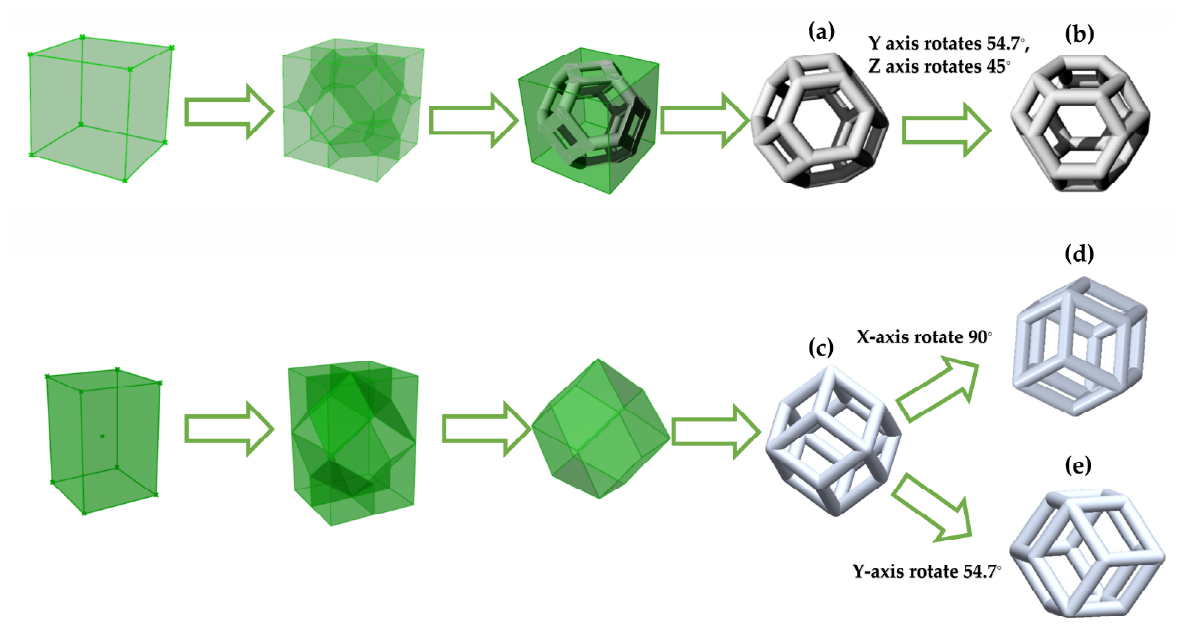
Figure 2. Design process of random Voronoi structure: ( a ) Octa-A, ( b ) Octa-B, ( c ) Dodeca-A, ( d ) Dodeca-B and ( e ) Dodeca-C. Table 1. Specific geometric parameters of the CAD